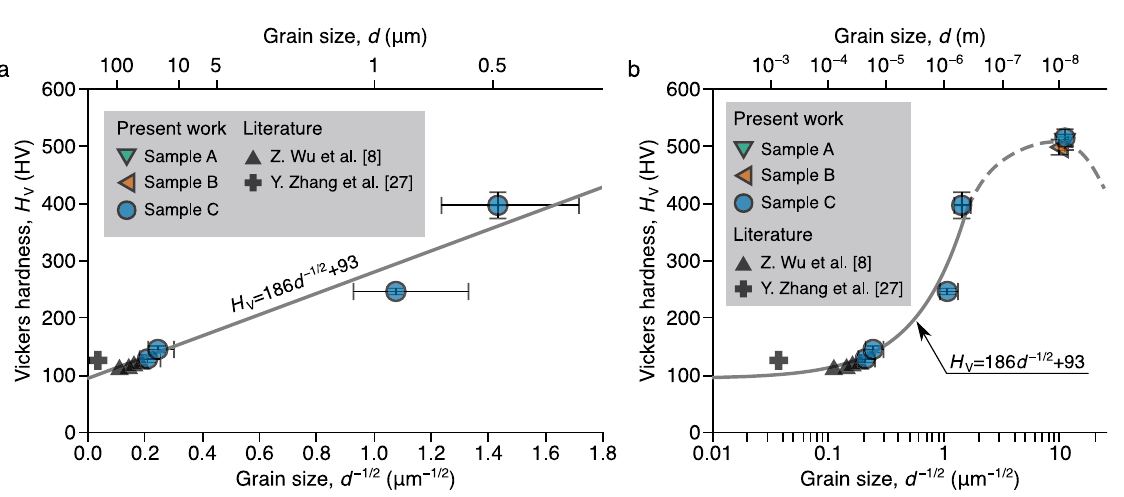
Figure 4. Hall–Petch relationship for the FeCoNi MEAs. Vickers hardness of the FeCoNi MEAs previously reported 8,27 and fabricated in this work on the Hall–Petch relationship presented in ( a ) linear and ( b ) log scales for grain size. The error bars present the standard deviation for measured grain size and